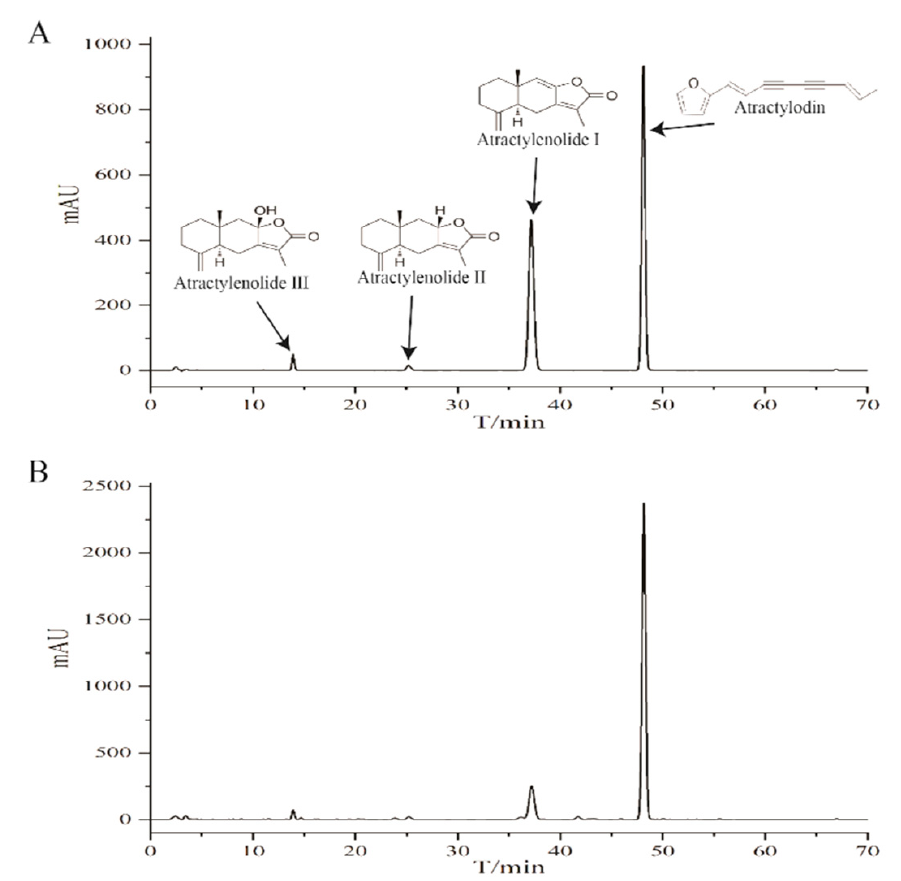
Figure 1. Chemical composition profile of EEAR. ( A ) Chromatogram of four mixed standards. ( B ) Chromatogram of EEAR.